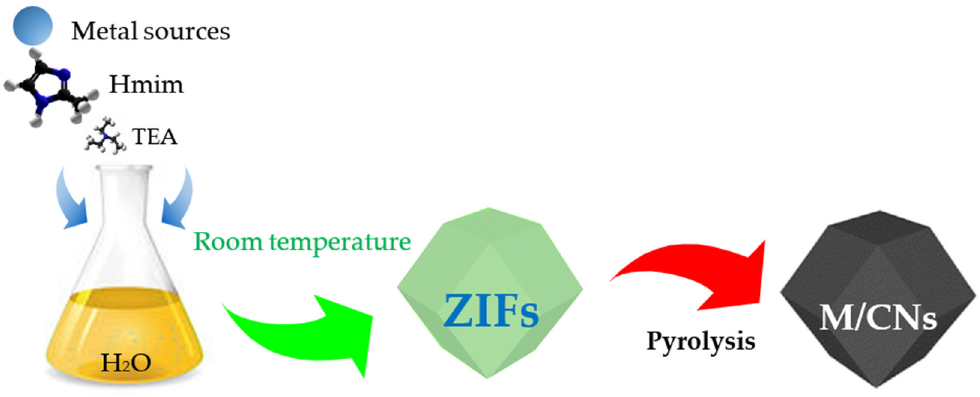
Figure 9. Schematic presentation of the synthesis procedure of N-doped porous carbonaceous materials deriving from zeolitic imidazole frameworks.